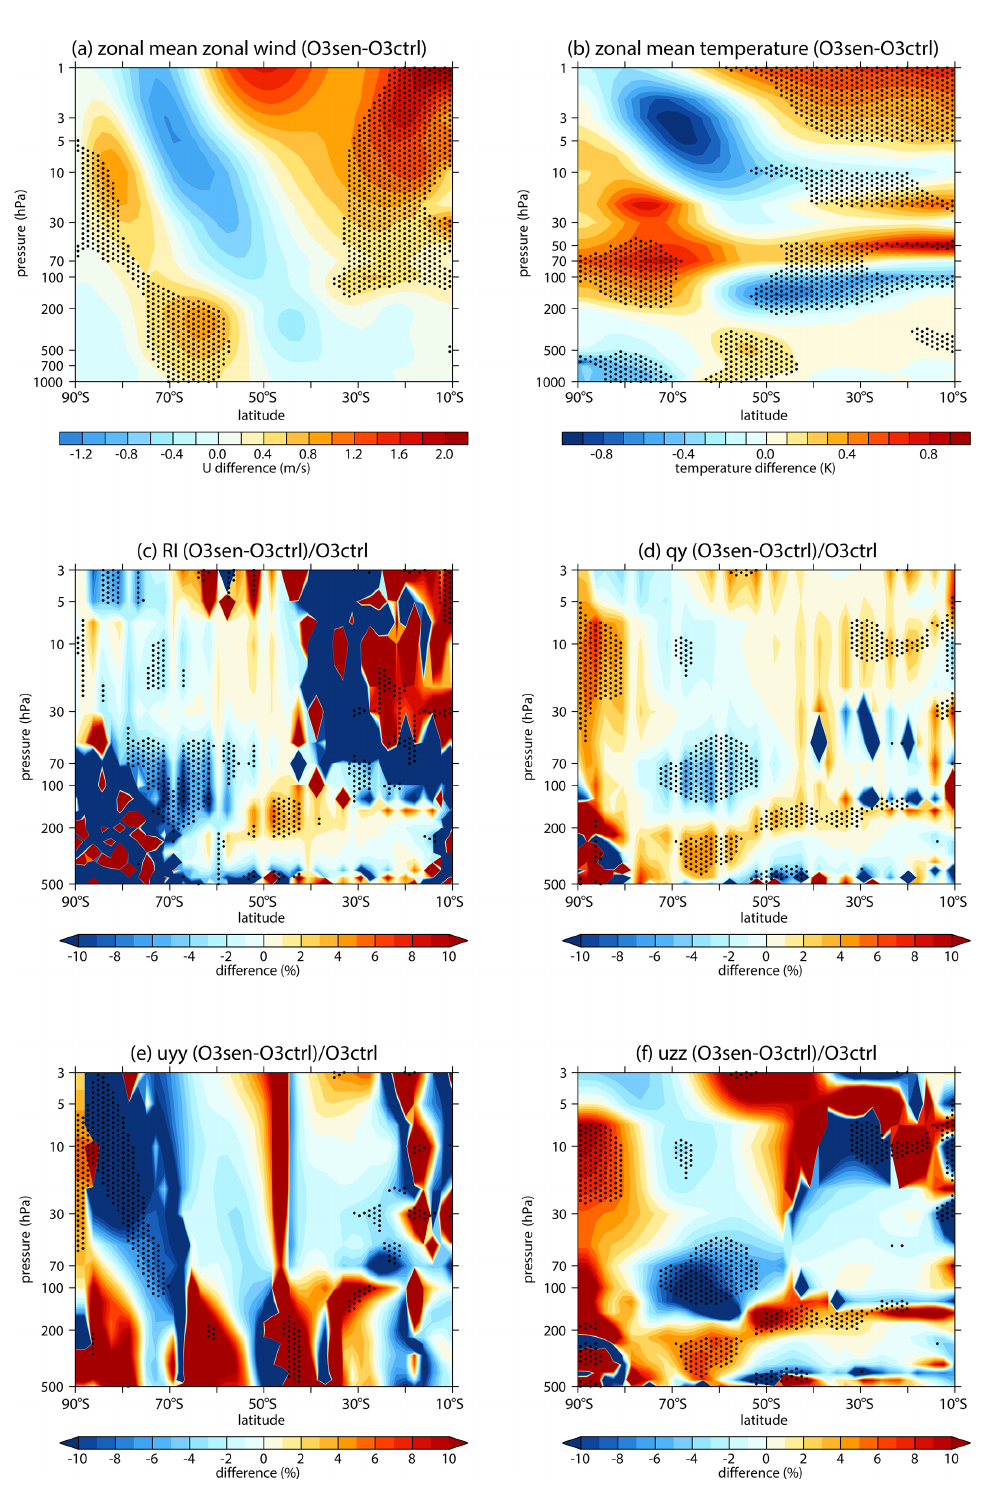
Figure 6. Differences in the (a) zonally averaged zonal wind, (b) zonally averaged temperature, (c) refractive index, (d) a 2 ¯ q ϕ , (cid:104) ( ¯ u cos ϕ ) (cid:105) ϕ (e) − (uyy term), and (f) − a cos ϕ ϕ ence significant at/above 90% confidence